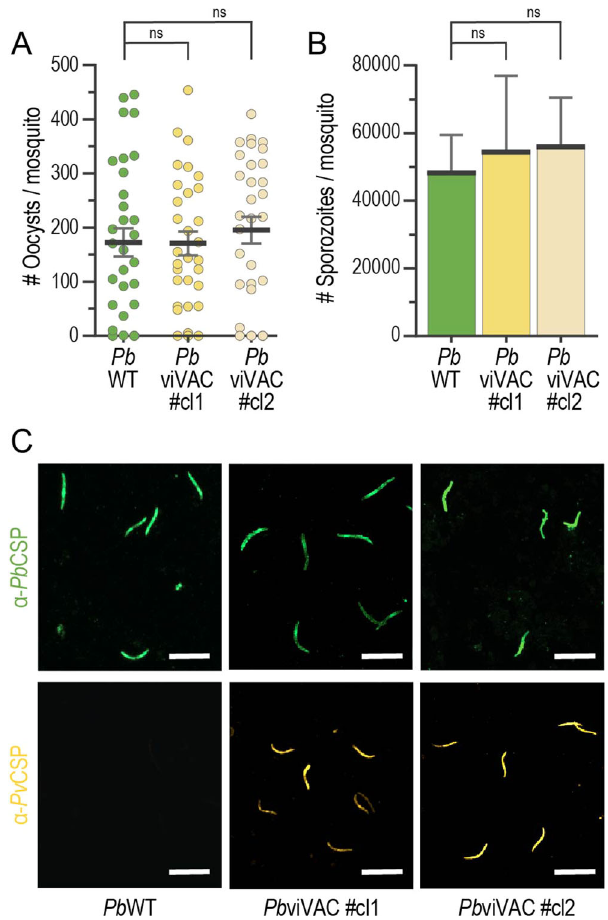
Fig. 2 Pb viVac sporogonic development and Pv CSP expression by salivary gland sporozoites. A, B Midgut oocyst and salivary gland sporozoite numbers in Pb WT and Pb viVac-infected mosquitoes ( n ≥ 28 mosquitoes per group); C Representative immuno fl uores- cence microscopy images of Pb CSP (green) and Pv CSP (yellow) expressed by Pb WT (left) and Pb viVac (middle and right) sporozoites. Scale bar: 20 µm. Measurements were taken from distinct samples. The black lines/bars and grey lines correspond to mean and standard error of the mean, respectively (ns: not signi fi cant, Mann – Whitney U